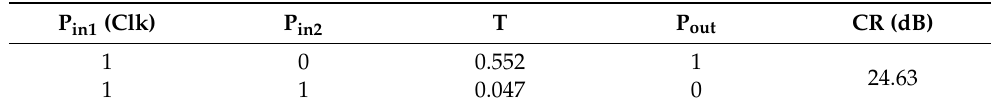
Table 5. Simulation findings for NOT (T th = 0.14).